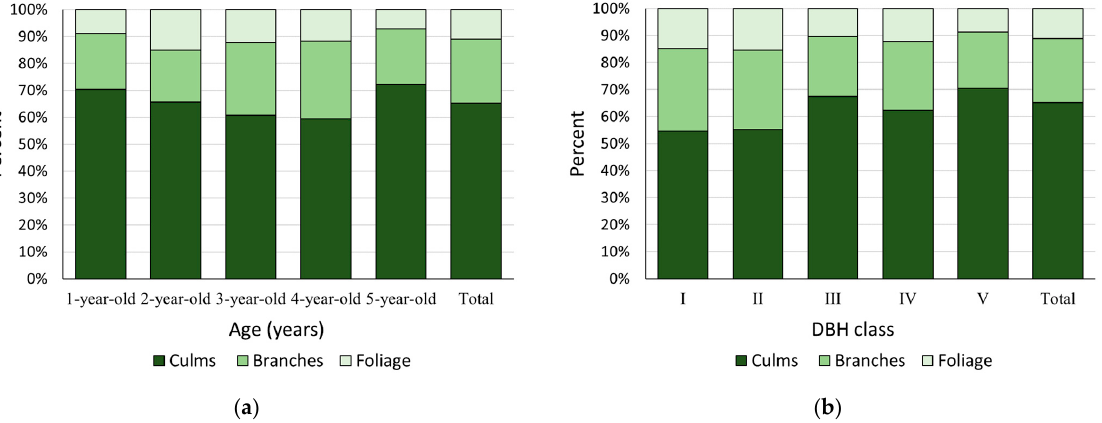
Figure 1. The proportion of foliage, branch and culm biomass to aboveground biomass by ( a ) age class and ( b ) DBH class.